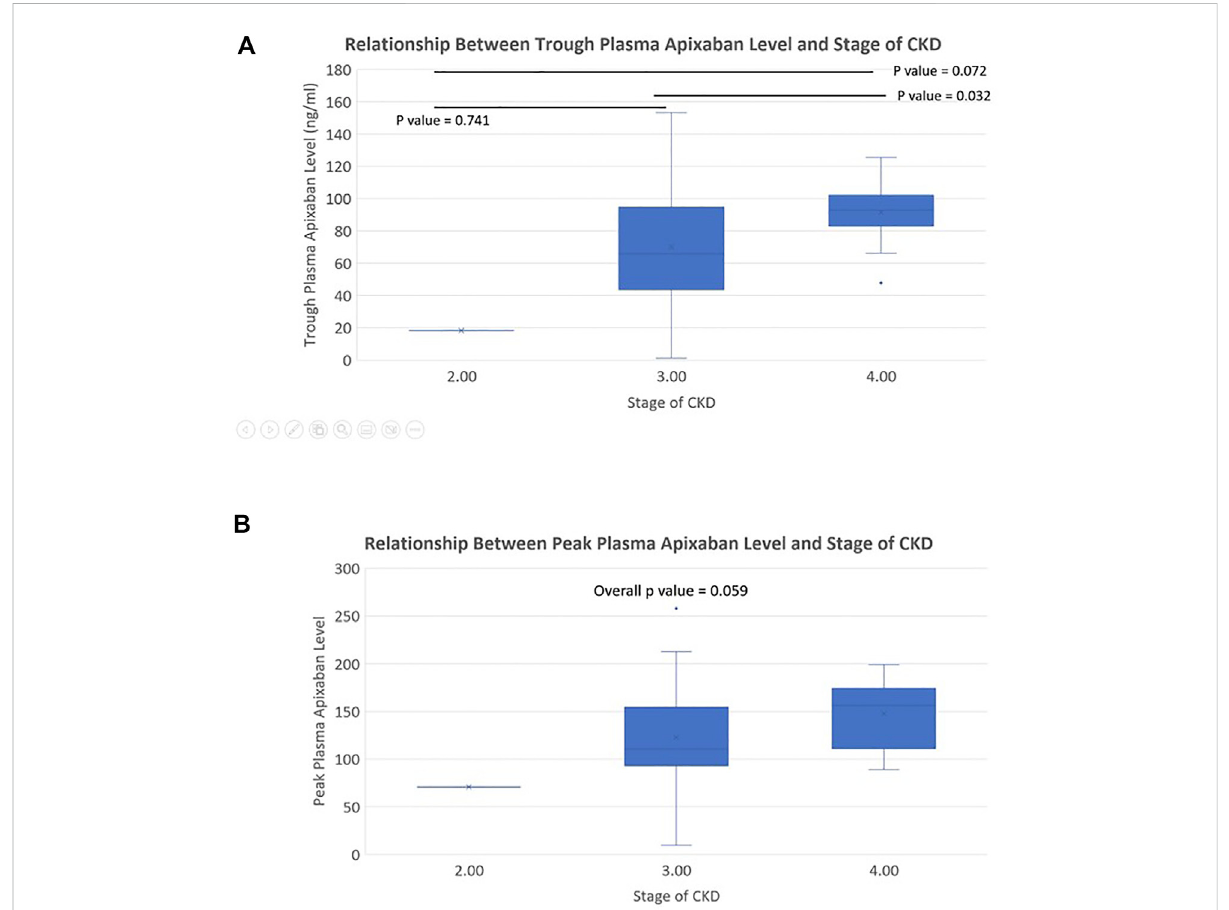
FIGURE 4 (A) Relationship between trough plasma apixaban level and stages of CKD (apixaban 2.5 mg twice daily). Difference of trough plasma apixaban level in patients with different stages ofCKD. The troughlevel of stage 3vs. stage 2 vs. stage 1CKD patients was 91.6 ± 18.8 ng/ml vs. 70.1 ± 38.2 ng/ mlvs.18.2 ng/ml,overall p -value < 0.05; Difference between stage3CKDvs. stage2CKD,stage3CKDvs.stage1CKD,stage 2CKDvs.stage1 CKD: p = 0.032 vs. 0.072 vs. 0.741). (B) Relationship between peak plasma apixaban level and stages of CKD (apixaban 2.5 mg twice daily). Difference of peak plasma apixaban level in patients with different stages of CKD. The peak level of stage 3 vs. stage 2 vs. stage 1 CKD patients was 147.6 ± 35.1 ng/ml vs. 122.9 ± 55.5 ng/ml vs. 70.5 ng/ml, overall p -value: